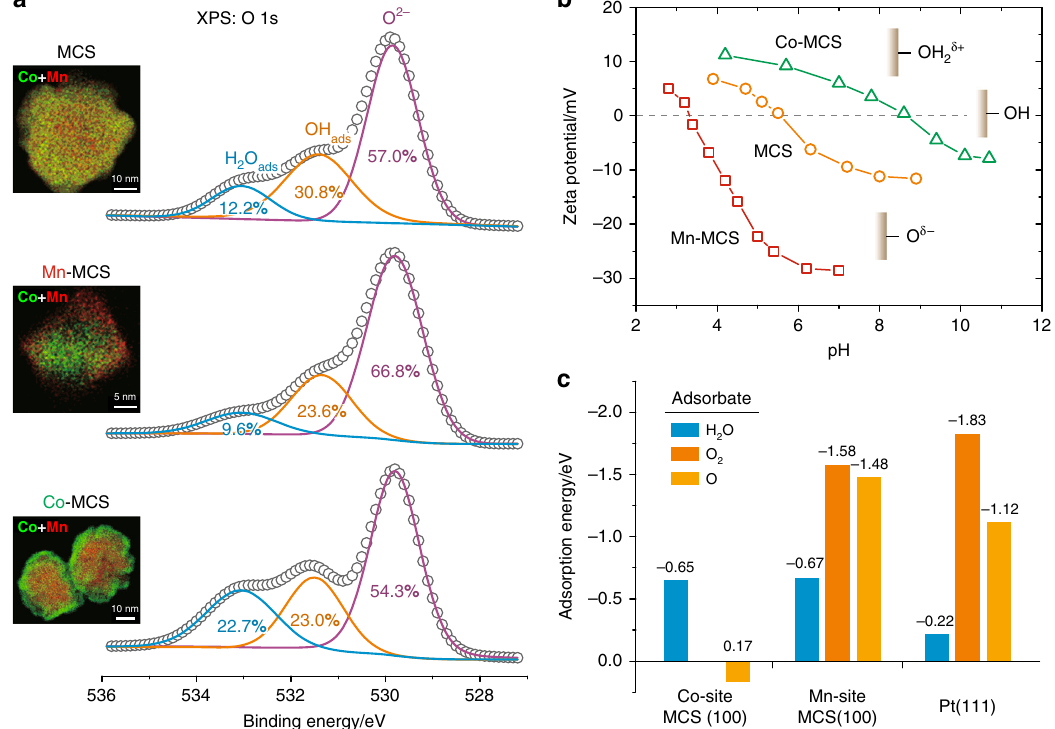
Fig. 3 Surface analyses of the Mn-Co catalyst. a Oxygen 1 s spectra of X-ray photoelectron spectroscopy (XPS) for MCS and two reference samples with Mn or Co enriched on the surface (denoted as Mn-MCS and Co-MCS, respectively). Insets are electron energy loss spectroscopy (EELS) mapping for